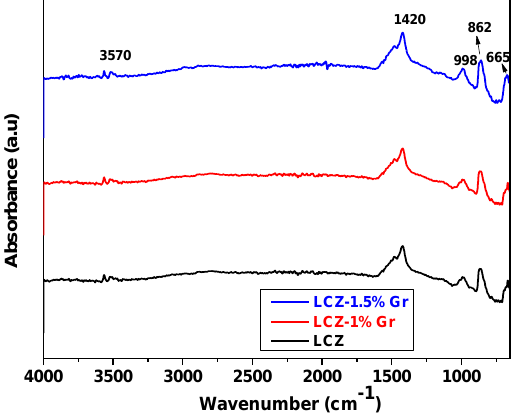
Figure 4. FTIR spectrum of prepared materials.